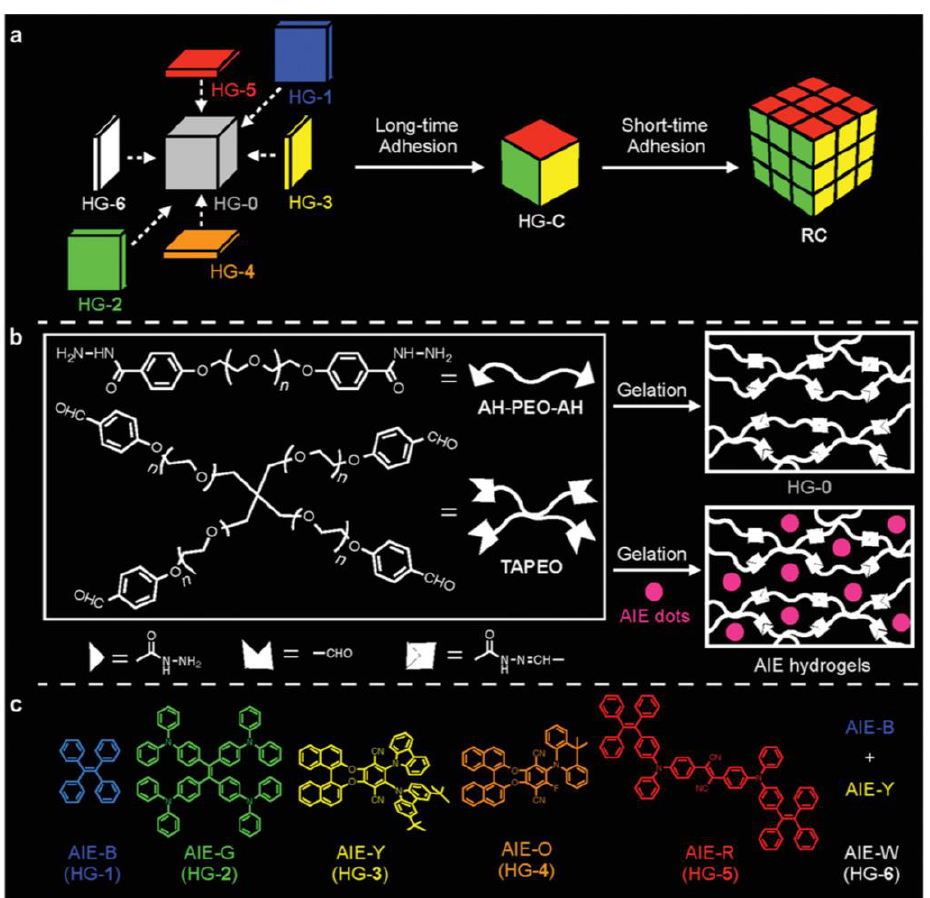
Figure 3. ( a ) Schematic diagram of chemical Rubik’s Cube (RC) preparation. ( b ) Chemical structures and representations of the hydrogels used in Ref. [44]. ( c ) Chemical structures of the AIEgens used in Ref. [44]. Reprinted with permission from Ref. [44]. Copyright 2019, Wiley-VCH.